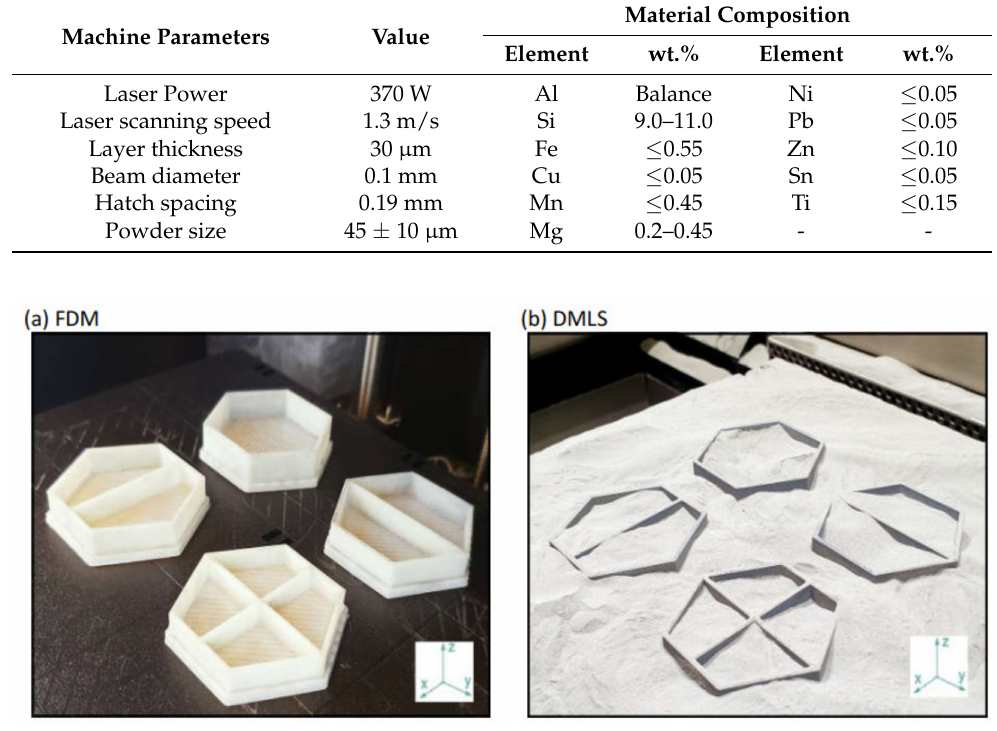
Figure 3. A photograph of the specimens on the building platform of ( a ) FDM and ( b ) DMLS machines. Upright (ZX) building orientation was